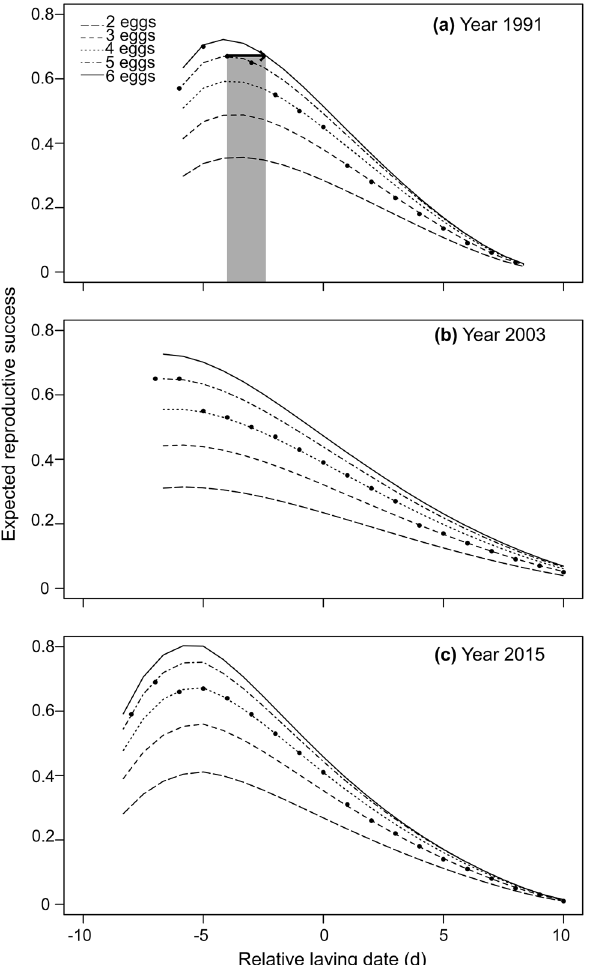
Figure 4. Expected reproductive success of greater snow geese in relation to relative laying date for birds laying a hypothetical clutch size of 2 to 6 eggs. Reproductive success is the number of offspring reaching 1 year of age. Figures show expected reproductive success at the beginning ( a ), half-way ( b ) and at the end ( c ) of the study period. Dots represent mean observed clutch size for each laying dates in those years. On panel ( a ), the black arrow and associated grey shading represents the maximum number of days (here, 1.6 days) that a bird about to lay 5 eggs on Day − 4 could delay laying to acquire enough nutrient to lay an extra egg and achieve a higher reproductive success (see text for